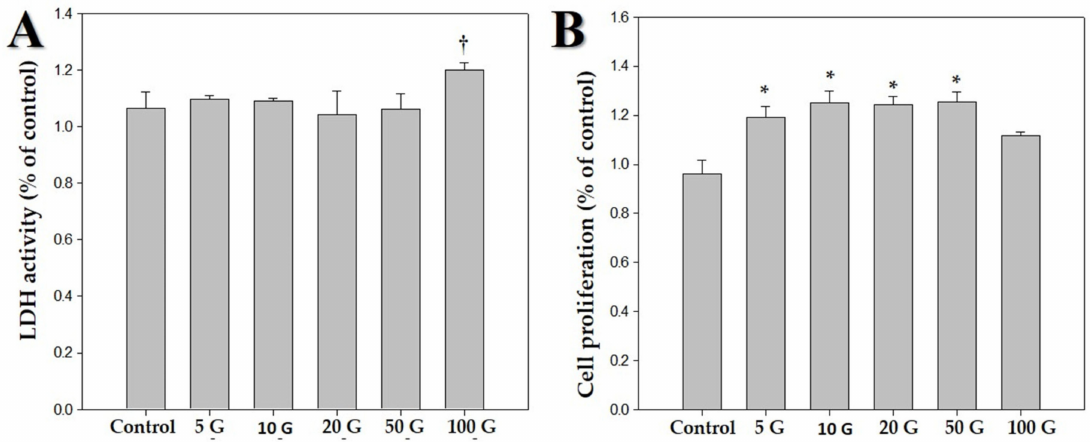
Figure 2. E ff ects of various intensities of extremely low frequency electromagnetic fields (ELF-EMFs; 5, 10, 20, 50, and 100 G) on human dermal papilla cells (hDPCs). The hDPCs (2 × 10 4 cells / well) were cultured in Dulbecco’s minimal essential medium for 48 h. ( A ) Cytotoxic e ff ects of ELF-EMFs on hDPCs. Their cytotoxicity was measured by using an LDH assay kit. ( B ) MTT assay was performed for determining viability of hDPCs after treatment with ELF-EMFs ( † p > 0.05, * p < 0.05, compared with the